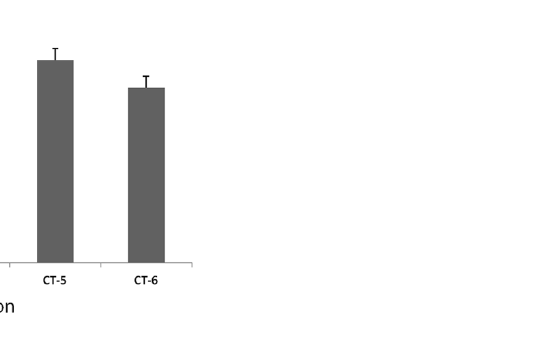
Figure 6. Total flavonoid content (TFC) of six C. tora